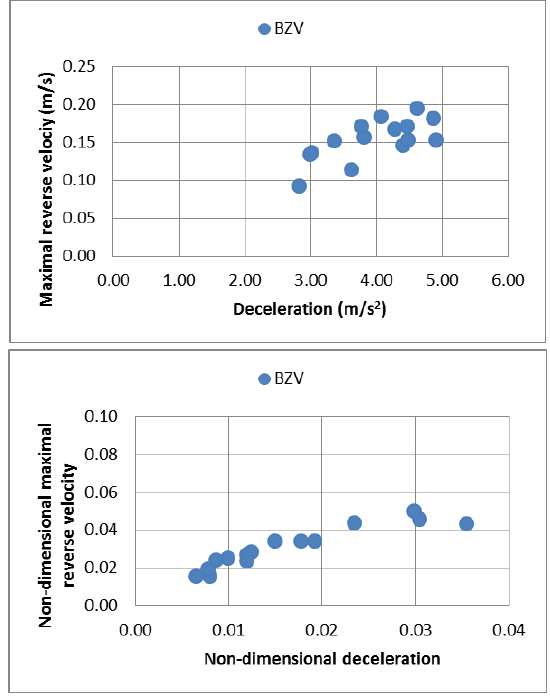
Fig. 13. Dynamic properties – reverse velocity dependence on system